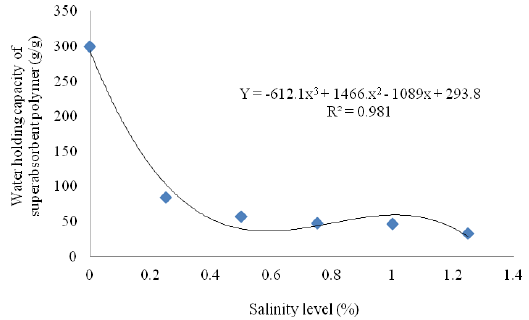
Fig. 1. Effect of water quality on water holding capacity by superabsorbent polymer